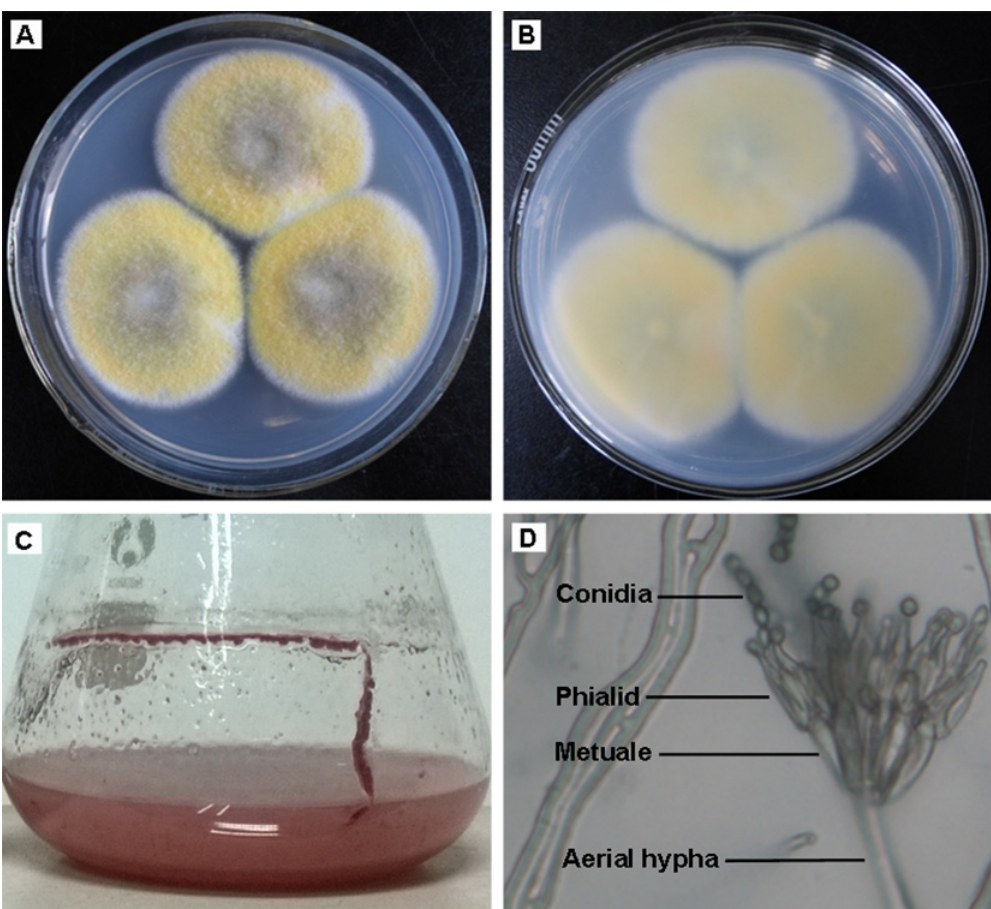
Fig 1. Morphological observation of fungal strain 1 – 95. Fungal strain 1 – 95 was cultivated using solid or liquid media, and then the morphological data were collected. (A) The obverse side of fungal strain 1 – 95. (B) The reverse side of fungal strain 1 – 95. (C) Fungal strain 1 – 95 produced red pigment when it was cultured using liquid isolating medium (containing 1% soluble starch). (D) The broom-like conidia generating structure and conidia of fungal strain 1 –